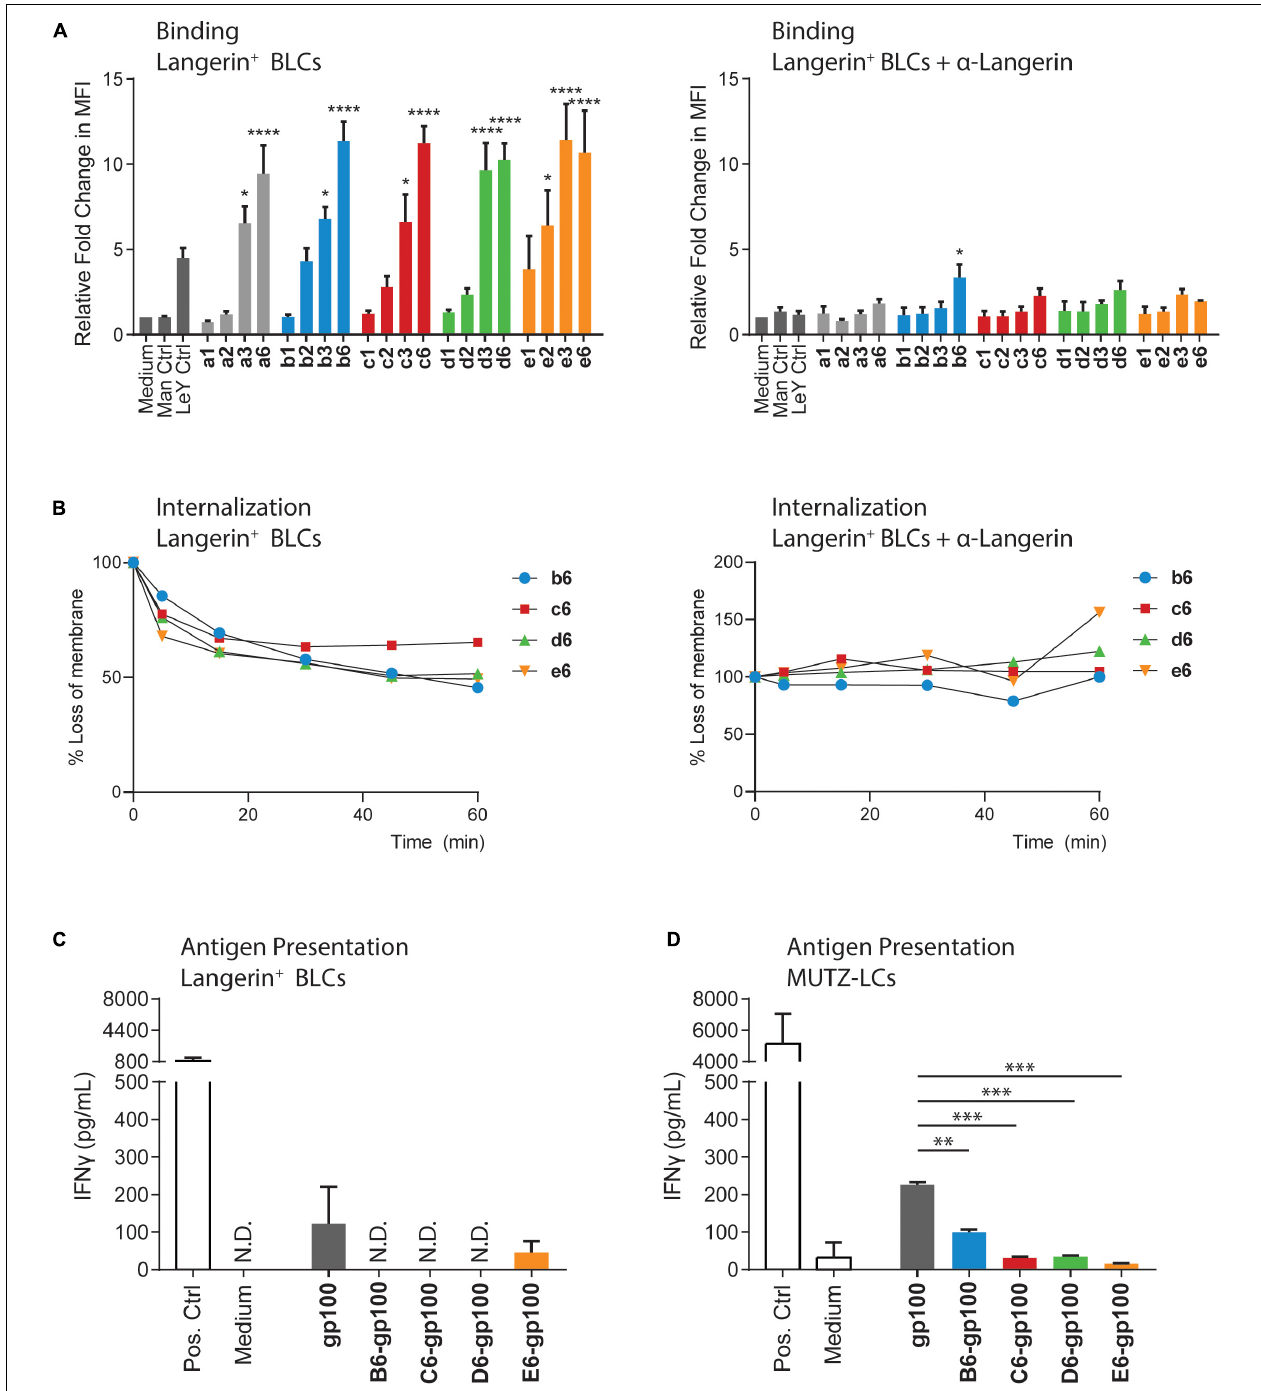
FIGURE 2 | The binding, internalization, and antigen presentation profiles of the mannoside clusters. (A) Binding of biotin-functionalized clusters to Langerin + BLCs was measured by flow cytometry. Normalized to medium, the binding profiles mirror the SPR data, where higher multivalent presentation of the saccharides significantly increases the receptor binding compared to medium. The binding is inhibited by blocking with a Langerin-binding antibody. (B) Internalization of the biotin-functionalized clusters by Langerin + BLCs was measured by flow cytometry. Internalization was normalized to the unstimulated control. One experiment is shown as representative of three individual experiments. b6, d6, and e6 are internalized after 30 min, whereas c6 remained longer at the surface. Blocking the Langerin receptor prevents the loss from the membrane. (C) Antigen presentation by the Langerin + BLCs was measured by IFN γ release of activated T cells. Mannosylated antigens are not presented. Low levels of E6-gp100 activated T cells could be measured, although at lower levels than for the gp100 control. Data are representative of three independent experiments with gp100 280 - 288 as positive control and are represented as average ± SD, N.D., not determined. (D) Antigen presentation by the MUTZLCs was measured by IFN γ release of activated T cells. Mannosylation of the gp100 antigen significantly reduced antigen presentation compared to the gp100 control. * p < 0.05, ** p < 0.01, and *** p < 0.001.